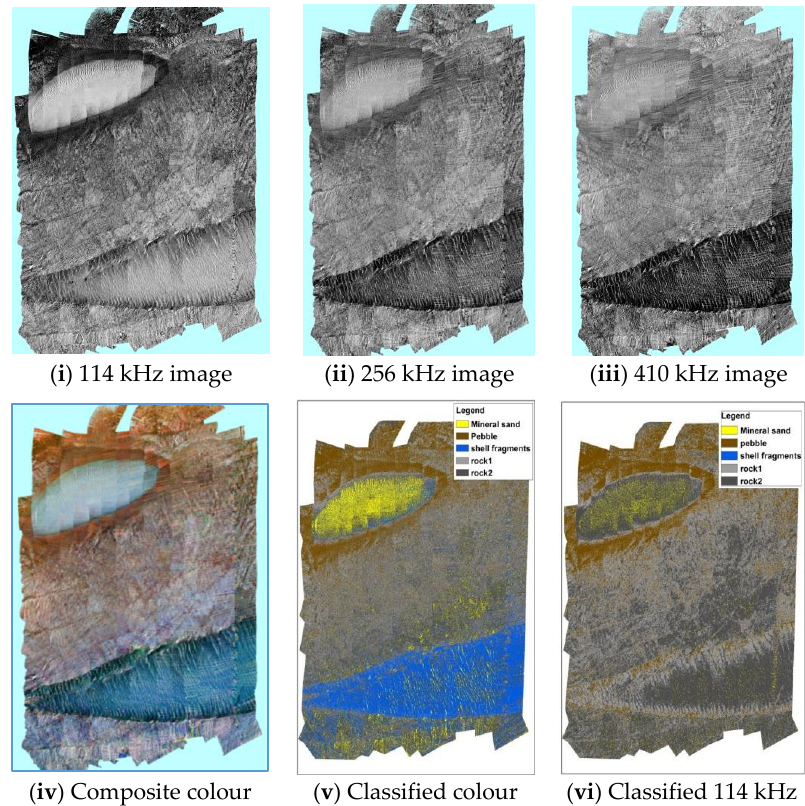
Figure 3. Figures respectively showing the frequency channels of (i) 114 ; (ii) 256 and (iii) 410 kHz of the study area for survey 1; Images represent an area of approximately 900 by 1130 m. The colour mosaic is shown ( iv ); ( v ) Supervised classification of the composite colour image; ( vi ) Supervised classification of the 114 kHz image.